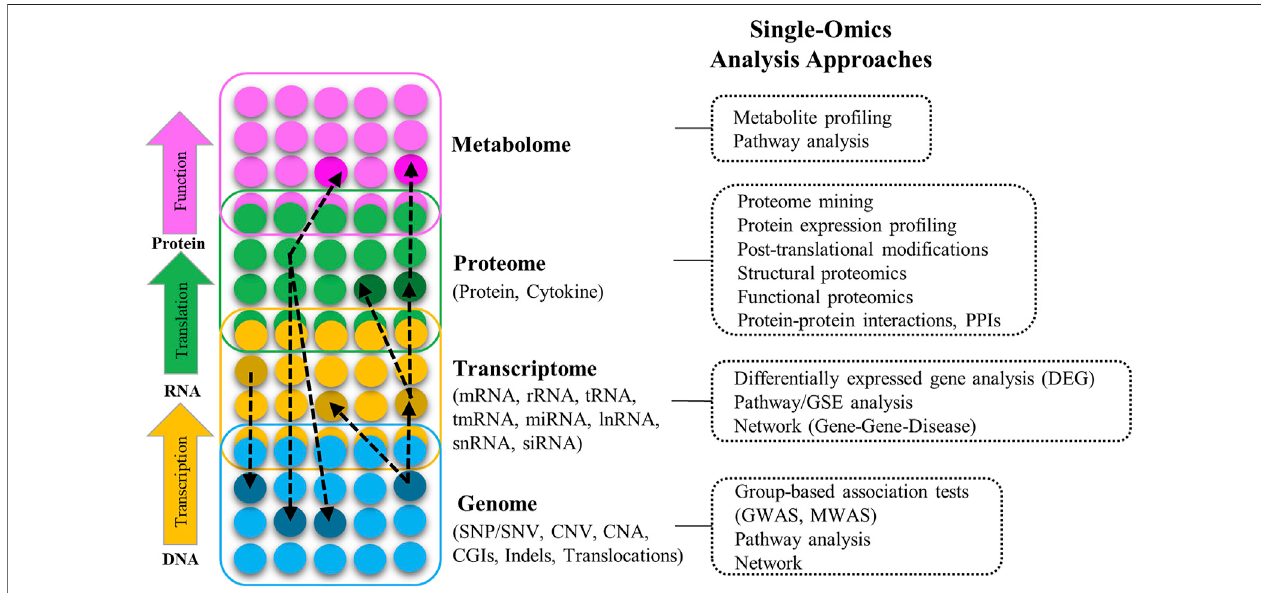
FIGURE 1 | Different layers of multi-Omics data (genome, transcriptome, proteome, metabolome), the interactions between them (black dashed-arrow), types of the Omics features in each layer, and different approaches to analyze Omics data in different layers (SNP: Single nucleotide polymorphism, SNV: Single nucleotide variation, CNV: Copy number variation, CAN: Copy number alternation, CGIs: CpG islands, Indels: Insertion and deletion, GWAS: Genome-wide association study, MWAS: Methylation-wide association study, RNA: Ribonucleic acid, mRNA: Messenger RNA, rRNA: Ribosomal RNA, tRNA: Transfer RNA, tmRNA: Transfer- messenger RNA, miRNA: Micro RNA, lncRNA: Long-noncoding RNA, snRNA: Small nuclear RNA, siRNA: Small interfering RNA, GSE: Gene-set enrichment).